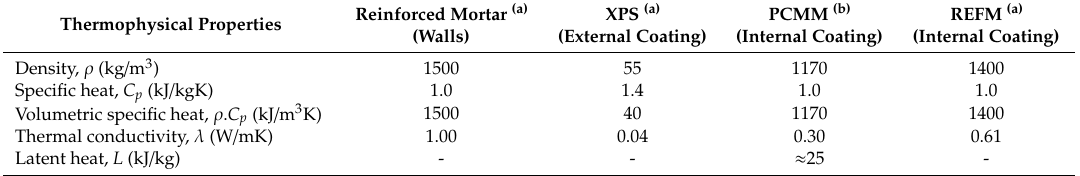
Figure 3. In situ monitoring of test cells—roof of the 1st floor of the building G, FEUP, Porto. Regarding the monitoring of temperatures, temperature sensors of the type “PT100”, with a sensitivity of +/ − 0.01 °C, were distributed inside the test cell, in a total of 10 sensors: 8 PT100s inside (4 in each cell) and 2 PT100s on the outside (near the bottom of each test cell). The distribution of temperature sensors inside the cells was done as follows: 1 PT100 in the center of the cover; 1 PT100 in the geometric center; 1 PT100 in the center of the base (bottom surface cell) and 1 PT100 in the center of the SE face (Figure 4). The sensors of temperature were connected to a data acquisition and storage system, with the recording of a measurement for every 10 min during the entire test cycle. Figure 4. Distribution of the sensors inside the test cells.